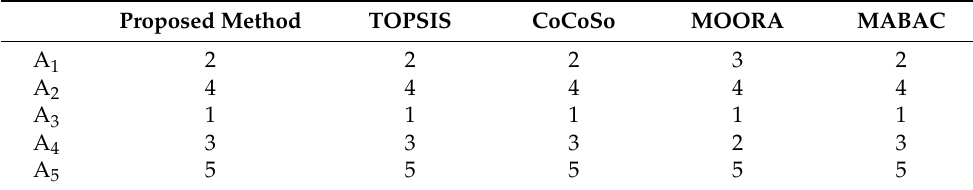
Table 10. Comparison of results calculated using different